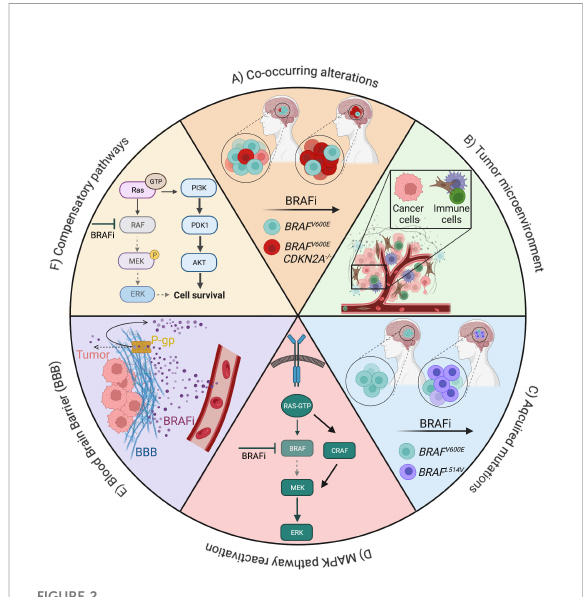
FIGURE 2 Overview of mechanisms of resistance to BRAF inhibitors (BRAFi) in gliomas. Drug resistance can be driven by cell-intrinsic factors, such as mutations (A, C) , pathway activation (D, F) , cell-extrinsic factors, such as the tumor microenvironment (B) , the presence of physical barriers like the blood brain barrier and its P- glycoprotein (E) . Examples of alterations and signaling pathways related to resistance to BRAFis in low- and high-grade gliomas are depicted (Created with